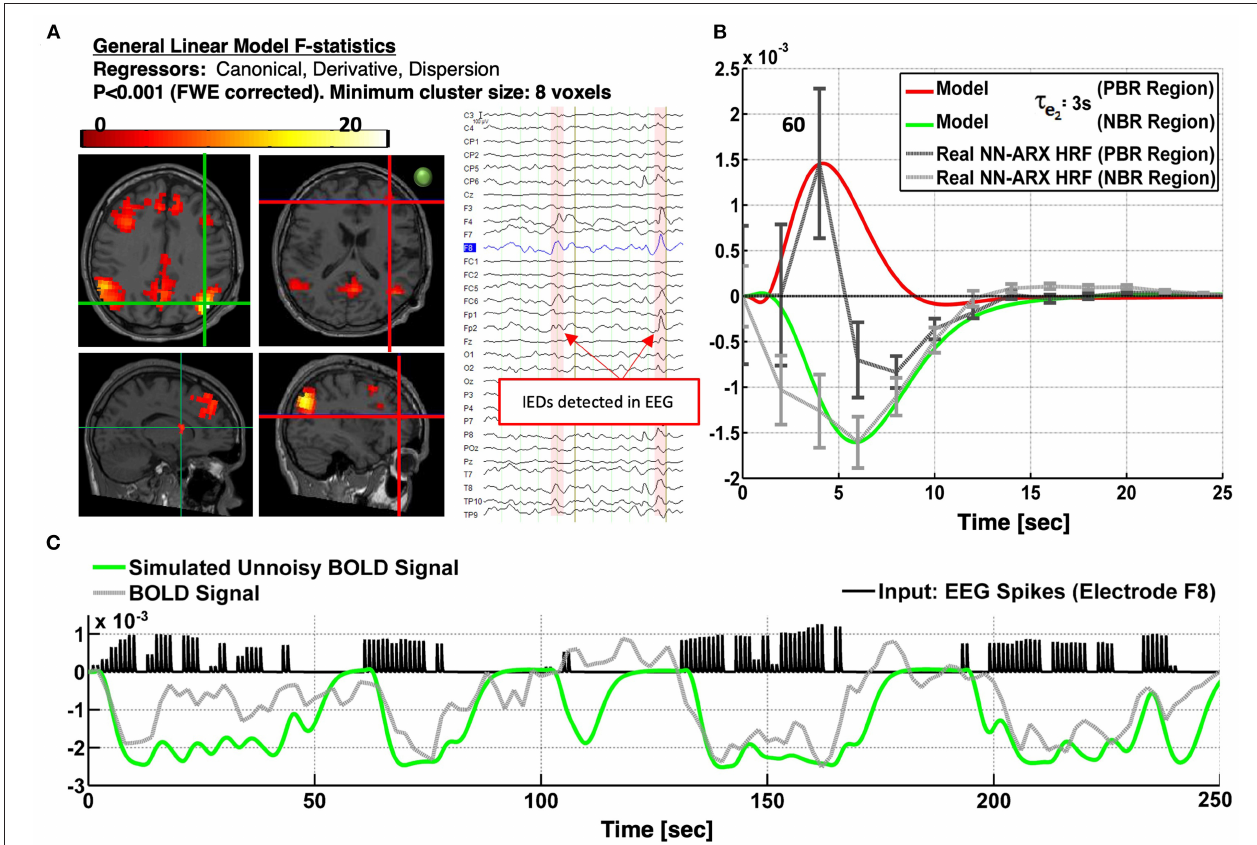
FIGURE 6 | Patients #3 shows an irritative zone with NDA-type HRF in a brain area of the DMN. (A) Slices showing the thresholded F-statistics map built from the estimated coefficients of the GLM overlaid on the T1-weighted image. Top left axial slice: green crosshair locating the center of one NBR region in the Right Lateral Parietal node of the DMN—coinciding with the maximum value of the F-statistics. Bottom left sagittal: green crosshair locating another NBR region in the caudate nucleus. Right slices: Red crosshair locating the center of the PBR region in the right frontal cortex-presumably in the origin of the IEDs. The IEDs were detected using the EEG signal in electrode F8. The approximate location of this electrode is shown with a green circle in the right axial slice to illustrate the possible relation of frontal PBR and the IEDs. The right inset shows a short segment of the preprocessed EEG data where 2 IEDs were identified. (B) The dark gray curve shows the estimated NN-ARx PBR-HRF and its confidence interval, estimated from the real data around the region marked by the red crosshair in (A) . The light gray curve shows the estimated NN-ARx NBR-HRF and its confidence interval, estimated from the real data around the DMN node marked by the green crosshair in the top left slice in (A) . The red and green curves show the unnoisy simulated PBR-HRF and NBR-HRF, respectively, for a τ e 2 = 3 s . (C) For illustration purposes, we also show the temporal behavior of the simulated neuronal activity and BOLD signal in the NBR region [with τ e 2 = 3 s ], the time series of the real fMRI and the input. To account for the actual relative effect of the IEDs, the amplitude of the input pulses was multiplied by the normalized power of the EEG in